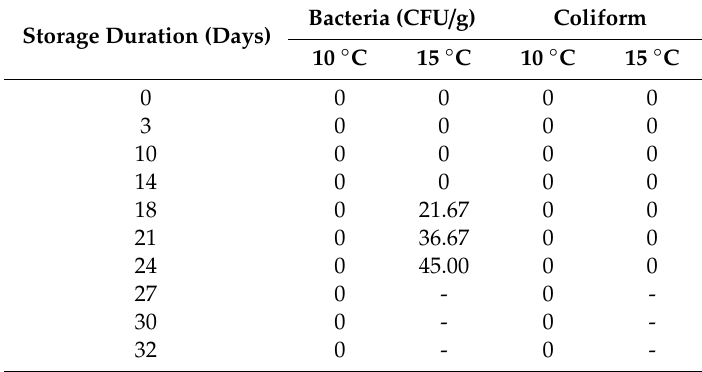
Table 1. Microbial activity of hot smoked HDPS during storage